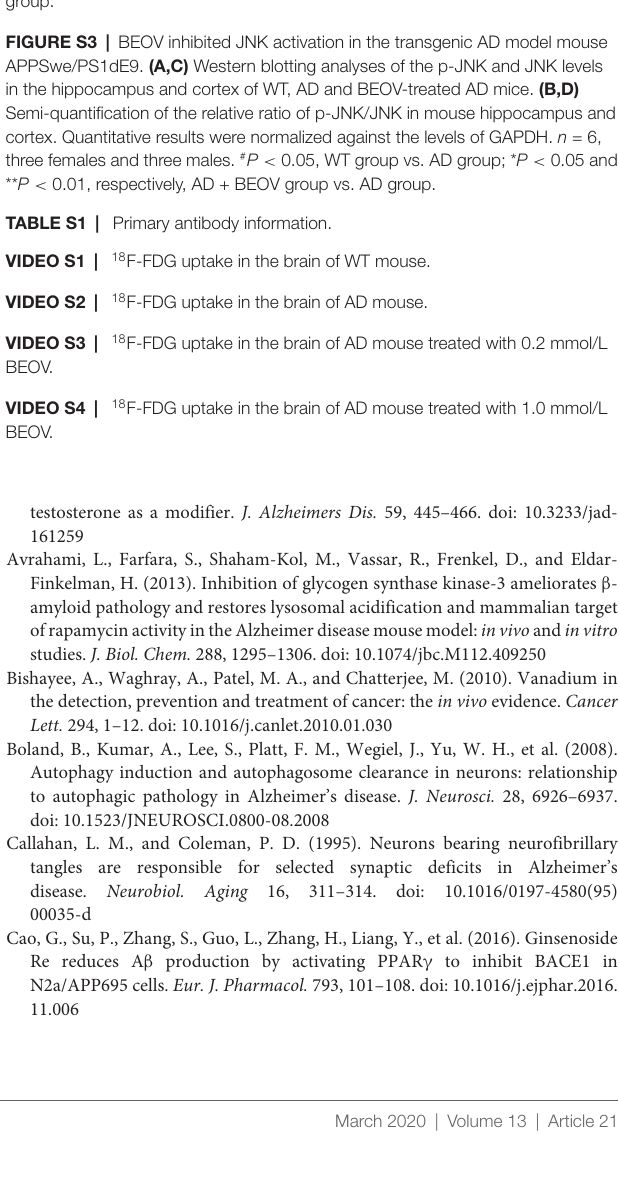
FIGURE S1 | The effect of BEOV on body weight, liver and renal function of the transgenic AD model mouse APPSwe/PS1dE9. (A) The body weights of WT, AD and BEOV-treated AD mice were measured, respectively. ( n = 12, six females and six males for each group). (B–D) Serum was collected from each AD or BEOV-treated AD mouse. The levels of aspartate transaminase (AST), creatinine and urea were measured, respectively. n = 6, three females and three males for each group. FIGURE S2 | The levels of vanadium increased both in the serum and brain of APPSwe/PS1dE9 AD mice after 3-month-treatment with BEOV. (A) Vanadium levels (ng/mL) in serum were measured after treating with BEOV for 3 months ( n = 10, five females and five males for each group). (B) Vanadium levels (ng/g) in the brain were measured after treating with BEOV for 3 months. n = 6, three females and three males for each group. *** P < 0.001, AD+BEOV group vs. AD group. FIGURE S3 | BEOV inhibited JNK activation in the transgenic AD model mouse APPSwe/PS1dE9. (A,C) Western blotting analyses of the p-JNK and JNK levels in the hippocampus and cortex of WT, AD and BEOV-treated AD mice. (B,D) Semi-quantification of the relative ratio of p-JNK/JNK in mouse hippocampus and cortex. Quantitative results were normalized against the levels of GAPDH. n = 6, three females and three males. # P < 0.05, WT group vs. AD group; * P < 0.05 and ** P < 0.01, respectively, AD + BEOV group vs. AD group. TABLE S1 | Primary antibody